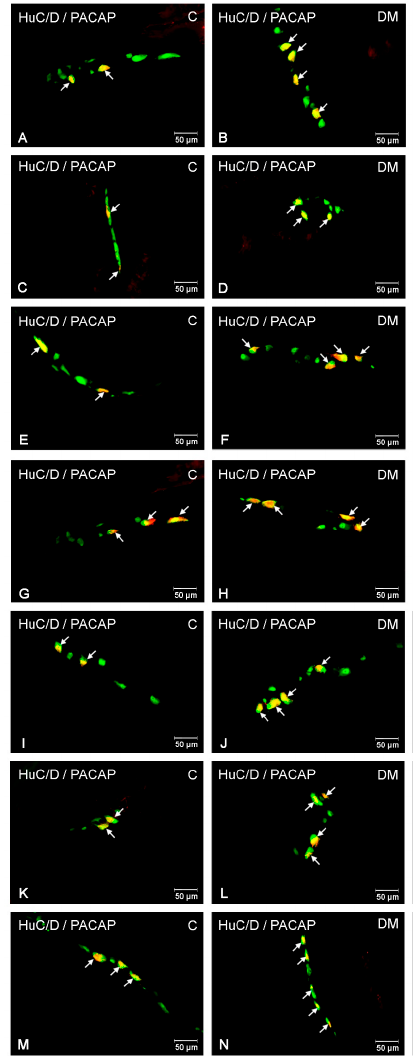
Figure 4. PACAP-LI enteric neurons in the porcine small intestine. ( A )—neurons immunoreactive to HuC/D (panneuronal marker) and PACAP in the myenteric plexus in the duodenum of control pigs; ( B )—neurons immunoreactive to HuC/D (panneuronal marker) and PACAP in the myenteric plexus in the duodenum of diabetic pigs, ( C )—neurons immunoreactive to HuC/D (panneuronal marker) and PACAP in the inner submucous plexus in the duodenum of control pigs; ( D )—neurons immunoreactive to HuC/D (panneuronal marker) and PACAP in the inner submucous plexus of diabetic pigs; ( E )—neurons immunoreactive to HuC/D (panneuronal marker) and PACAP in the myenteric plexus in the jejunum of control pigs; ( F )—neurons immunoreactive to HuC/D (panneuronal marker) and PACAP in the myenteric plexus in the jejunum of diabetic pigs; ( G )—neurons immunoreactive to HuC/D (panneuronal marker) and PACAP in the outer submucous plexus in the jejunum of control pigs; ( H )—neurons immunoreactive to HuC/D (panneuronal marker) and PACAP in the outer submucous plexus in the jejunum of diabetic pigs; ( I )—neurons immunoreactive to HuC/D (panneuronal marker) and PACAP in the myenteric plexus in the ileum of control pigs; ( J )—neurons immunoreactive to HuC/D (panneuronal marker) and PACAP in the myenteric plexus in the ileum of diabetic pigs; ( K )—neurons immunoreactive to HuC/D (panneuronal marker) and PACAP in the outer submucous plexus in the ileum of control pigs; ( L )—neurons immunoreactive to HuC/D (panneuronal marker) and PACAP in the outer submucous plexus in the ileum of diabetic pigs; ( M )—neurons immunoreactive to HuC/D (panneuronal marker) and PACAP in the inner submucous plexus in the ileum of control pigs; ( N )—neurons immunoreactive to HuC/D (panneuronal marker) and PACAP in the inner submucous plexus in the ileum of diabetic pigs. All pictures were created by digital superimposition of two colour channels (green for HuC/D and red for